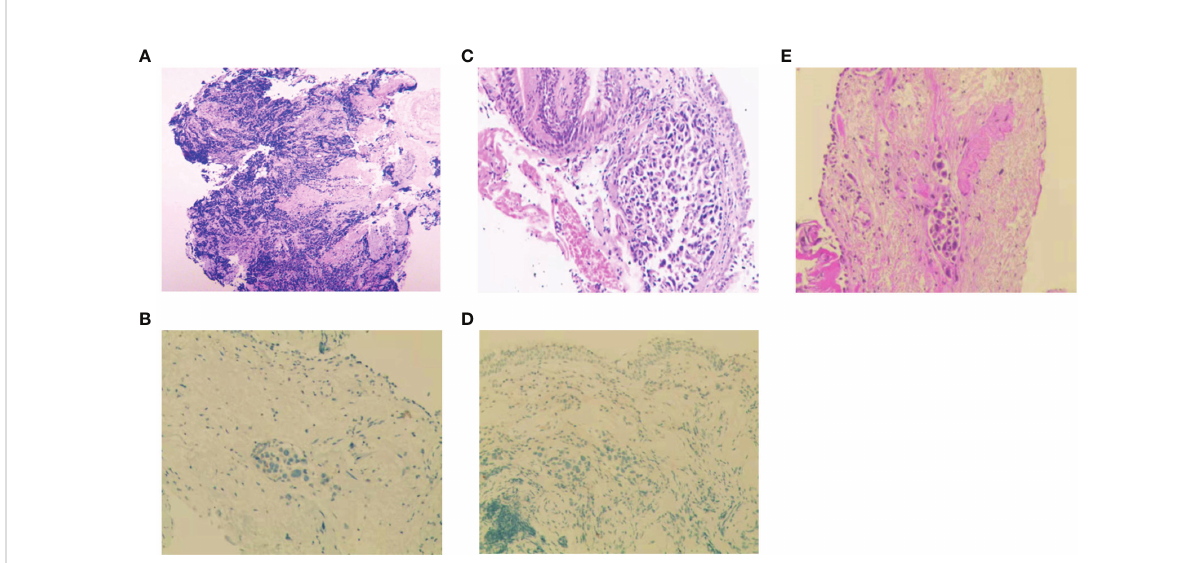
FIGURE 2 Histopathologic analysis at initial diagnosis, during and after treatment. (A-D) H&E staining and IHC analysis of Napsin-A at initial diagnosis (A, B) , at the fi rst relapse (C, D) . (E) H&E staining after icotinib resistance.